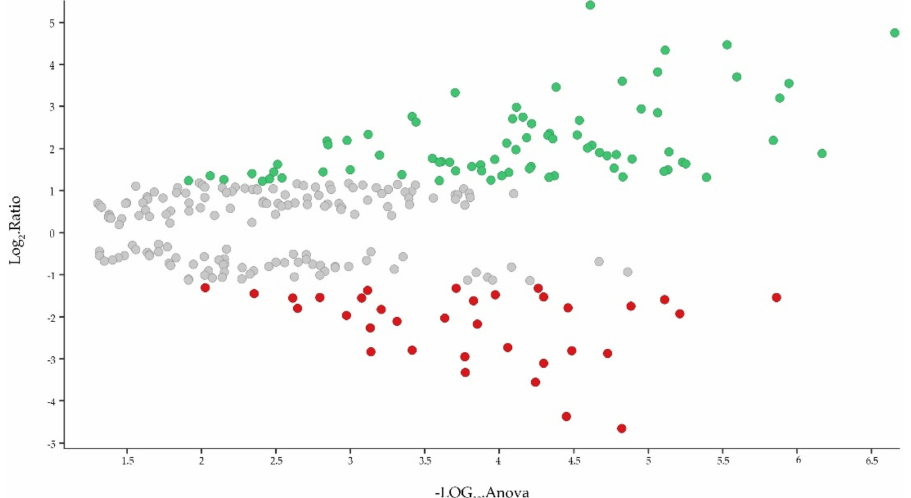
Figure 2. Volcano plot representing all filtered proteins. Gray circles unchanged proteins, green circles 77 up-regulated proteins, red circles 34 down-regulated proteins. y axis, ratio of the average of Hi3 intensities (ALPS-U/C) for each detected protein (values are represented as Log 2 ). x axis, p -value of each detected protein in the triplicate (values represented as − Log 10